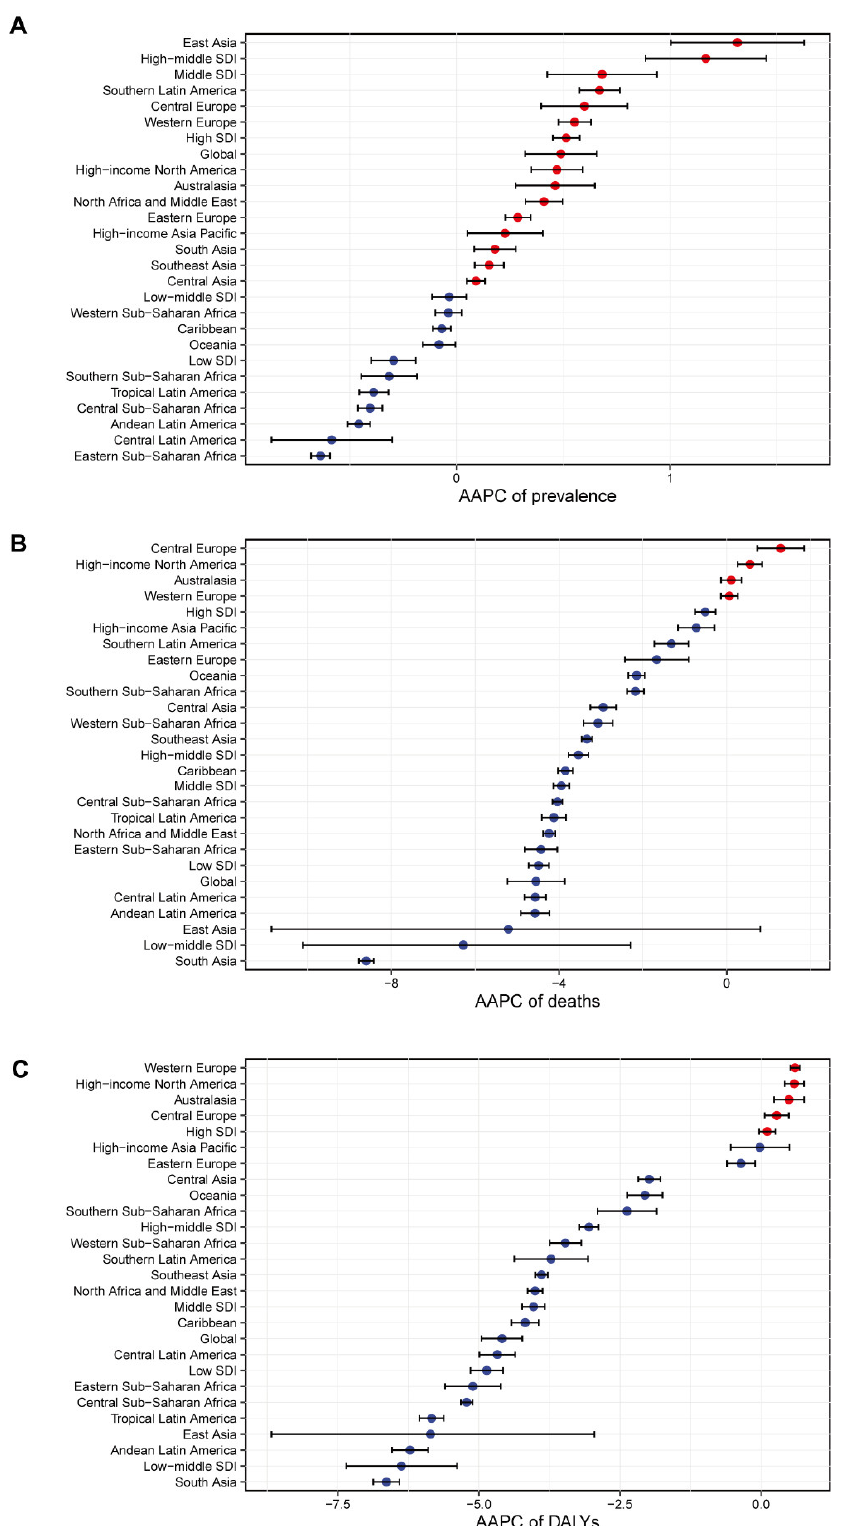
Figure 1. Average annual percentage change (AAPC) of the ( A ) age-standardized prevalence rate, ( B ) age-standardized death rate, and ( C ) age-standardized disability-adjusted life year rates for protein–energy malnutrition from 1990 to 2019. AAPC was obtained representing the average percent increase or decrease in PEM rates per year over each specified period of time to summarize and compare these trends over the entire time period. Red dot represents a AAPC value greater than zero, while blue dot represents a AAPC value less than zero.